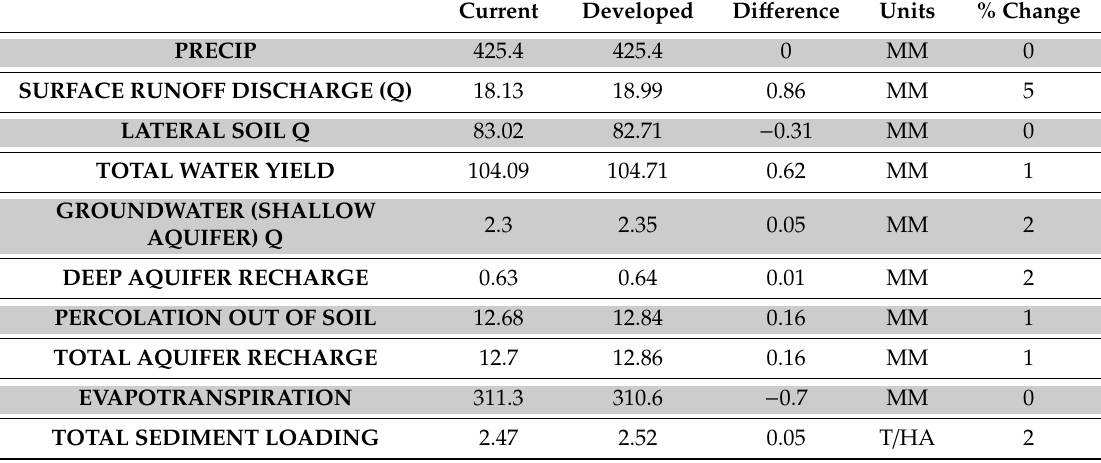
Table 1. Di ff erences in average annual basin output values between Current and Developed scenarios. Current Developed Di ff erence Units % Change PRECIP